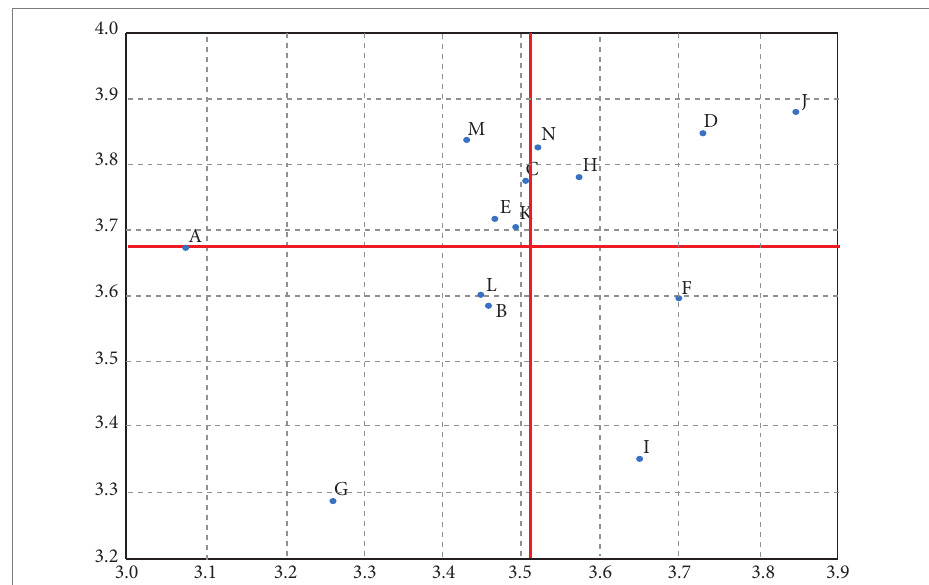
Fig. 12. The scatter diagram of parameters of relations of Slovak enterprises with the investor/investor’s